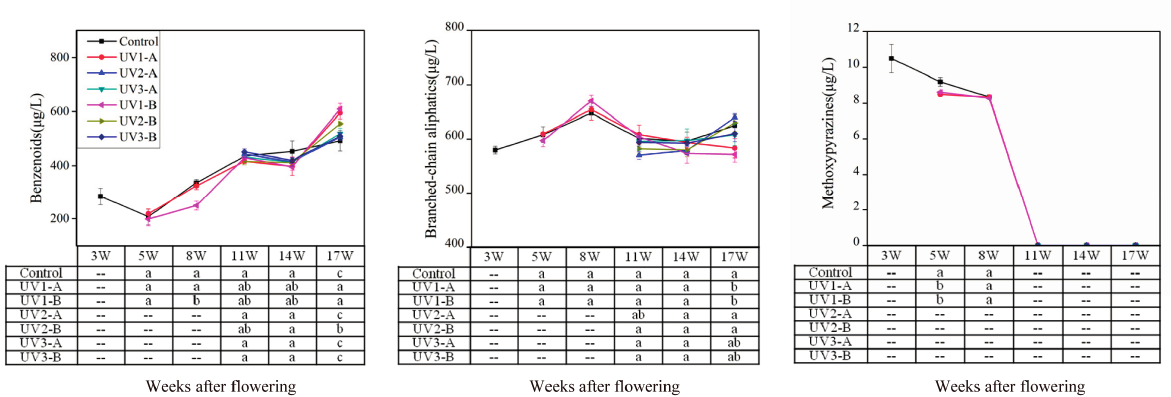
Figure 4. Effect of attenuated UV radiation n the concentration of amino acid-derived volatiles in developing “Cabernet Sauvignon” grapes. For more information, please refer to the explanation in Figure